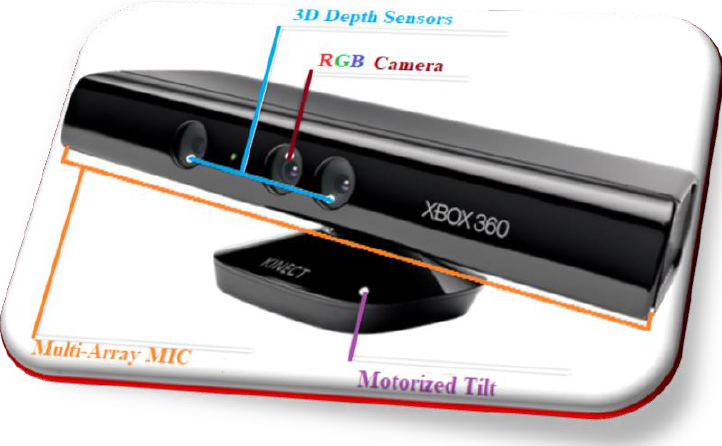
Figure 29. Microsoft Kinect Sensor.